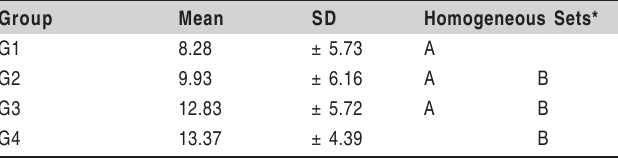
Table 1. The mean values, standard deviation (SD) and results of the Tukey’s